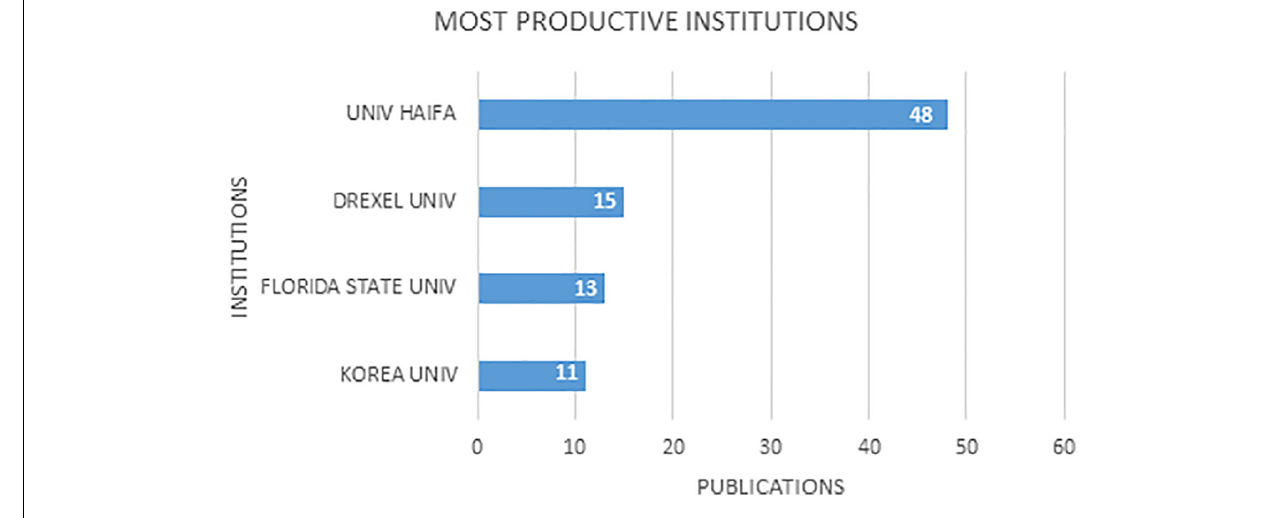
FIGURE 3 | Most productive institutions in art therapy, based on the data analyzed.